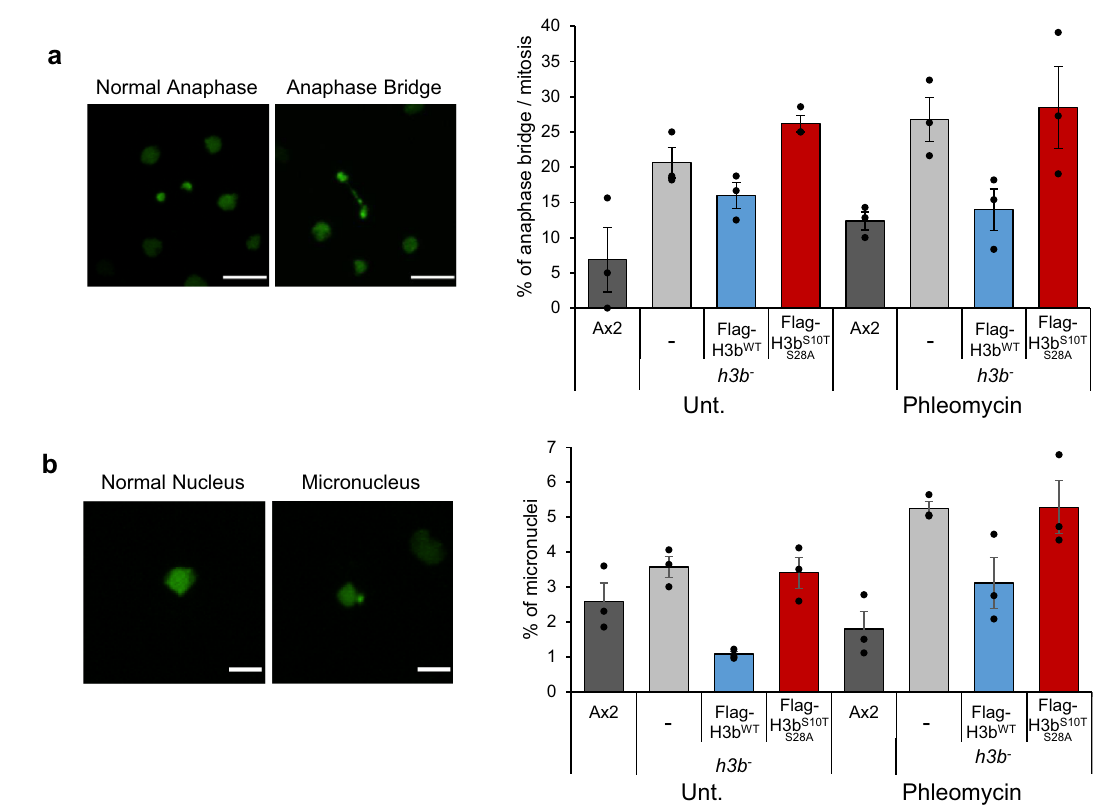
Fig. 6 H3b ADP-ribosylation is required for faithful completion of cytokinesis. a Ax2, h3b − cells, or h3b − cells expressing Flag-H3b WT or Flag-H3b S10T S28A expressing GFP-H2B were assessed for anaphase bridges during cytokinesis in either untreated cells, or cells exposed to phleomycin. A representative image of an anaphase bridge is illustrated (left panel) and quanti fi cation of data from three independent experiments (right panel). Scale bars: 10 μ m. b Ax2, h3b − cells, or h3b − cells expressing Flag-H3b WT or Flag-H3b S10TS28A expressing GFP-H2B were assessed for the presence of micronuclei in either untreated cells, or cells exposed to phleomycin. A representative image of a micronucleus is illustrated (left panel) and quanti fi cation of data from 3 independent experiments (right panel). Scale bars: 5 μ m. Source data are provided in the Source Data fi